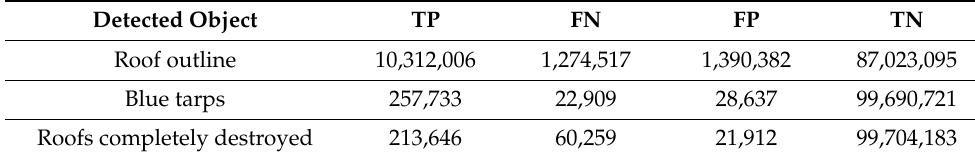
Table 4. Results of each detection target.